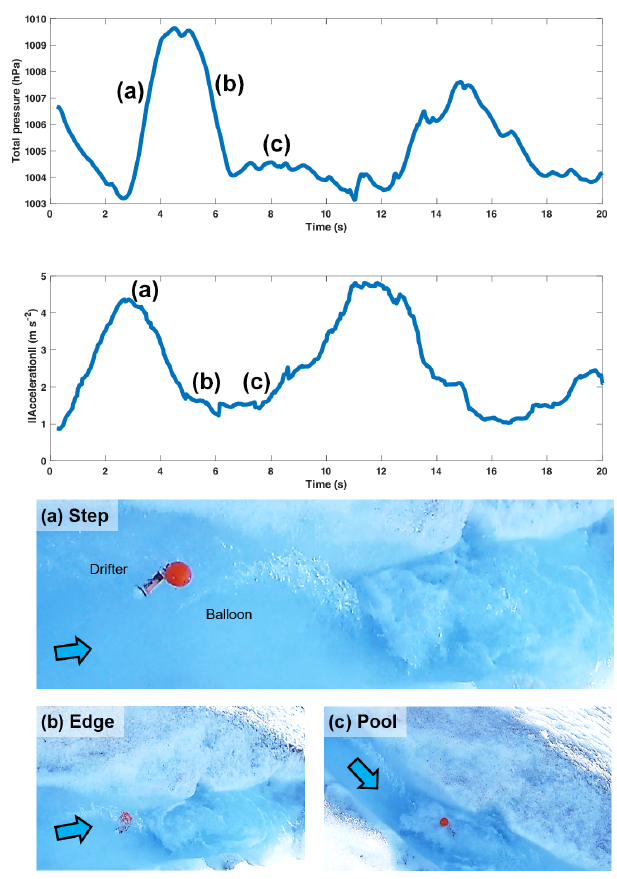
Figure 9. Example data of a drifter going over a step-pool sequence. The plot shows the left pressure record as well as the magnitude of the acceleration from a single drifter, while passing over a step-pool sequence. The data are averaged over a 2.5s time window. Three zones are marked on the plot, which represent different parts of the passage. (a) The acceleration and the total pressure increase as the drifter travels towards the edge of the step. (b) The acceleration and the total pressure drop as the drifter flows over the edge. (c) Nearly constant acceleration and pressure values while the drifter is caught in an eddy inside the